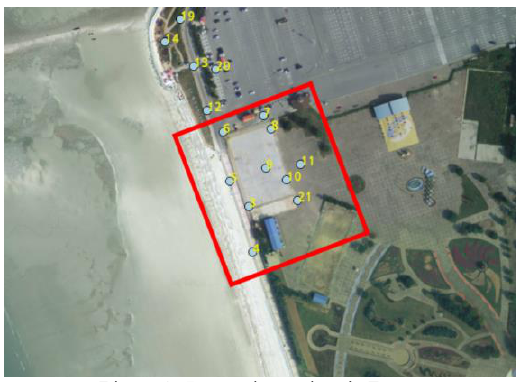
Figure 9. Inspection points in